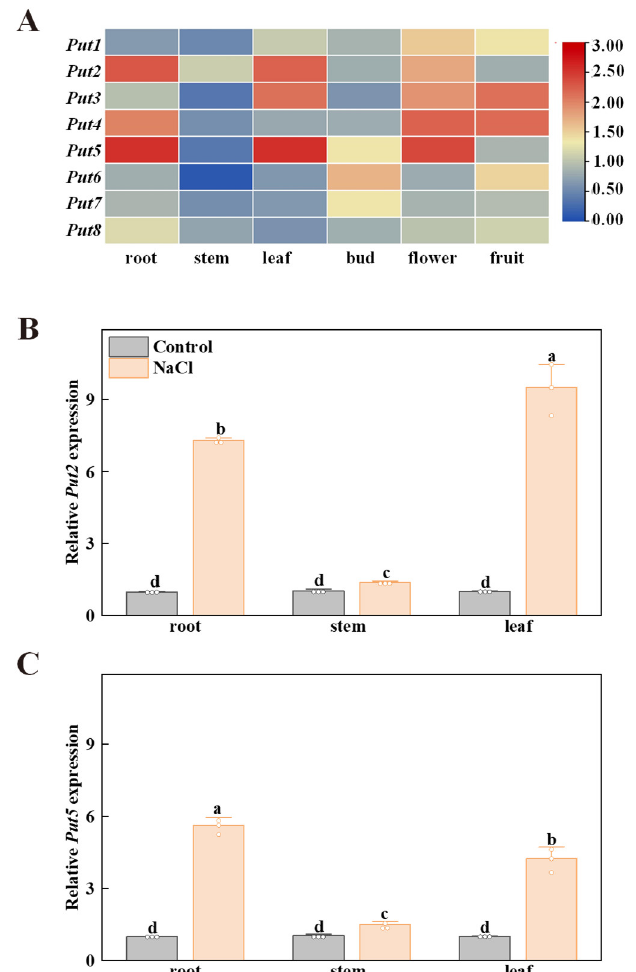
Figure 3. The expression profiles of the tomato Put family of genes in different tissues. ( A ) Heatmap representation of the relative expression of Put genes in different tomato tissues. The scale (0 to 3) represents the expression level (from low to high). ( B , C ) The spatial expression of Put2 and Put5 were performed by qRT-PCR in different organs of WT plants without NaCl (Control) and salt stress (NaCl) (7 days salt treatment). The WT expression in the control condition was set to 1. The data in B and C are presented as mean values ± SD; n = 3. Different letters indicate significant differences between treatments ( p < 0.05, Duncan’s multiple range test). Three independent experiments were performed with similar